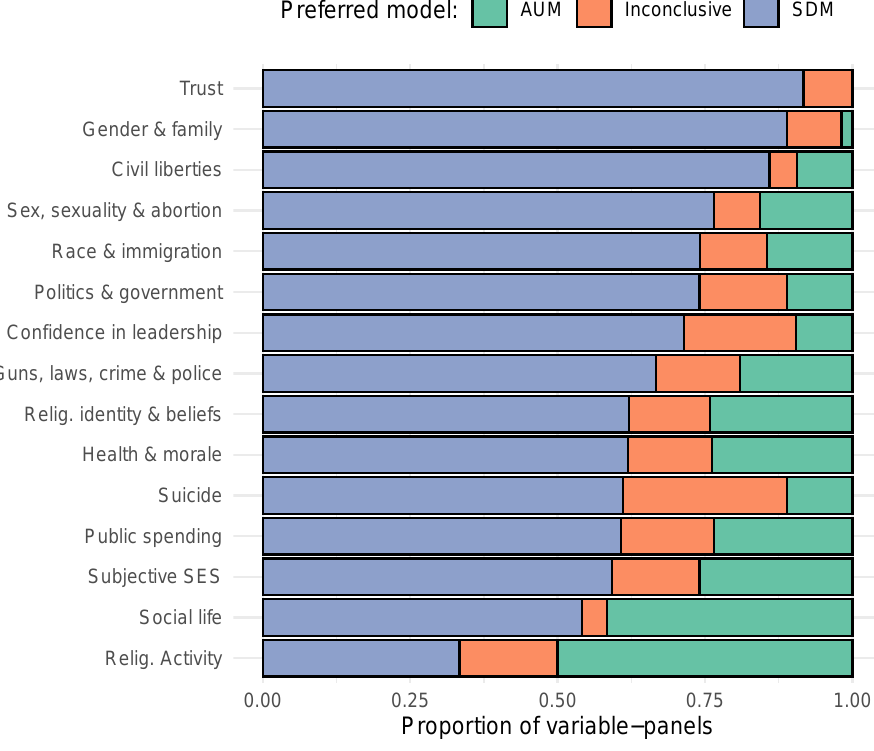
Figure 5: Proportion of variable-panels preferred by each model, by subject category. SES, socioeconomic